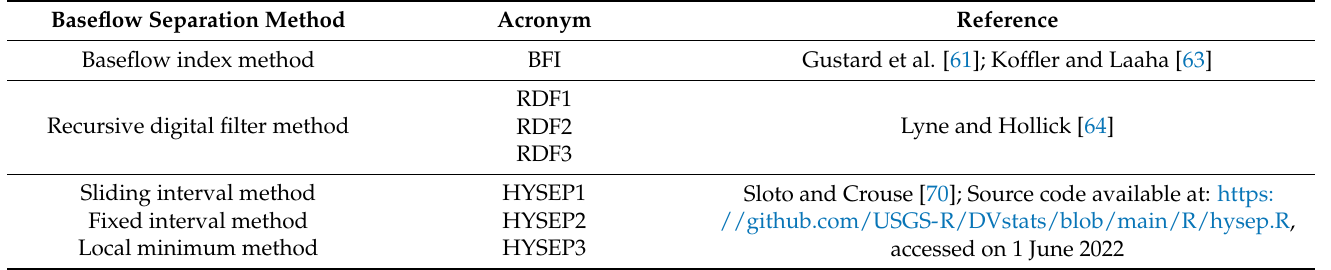
Table 2. Overview of the baseflow separation methods applied and tested in this